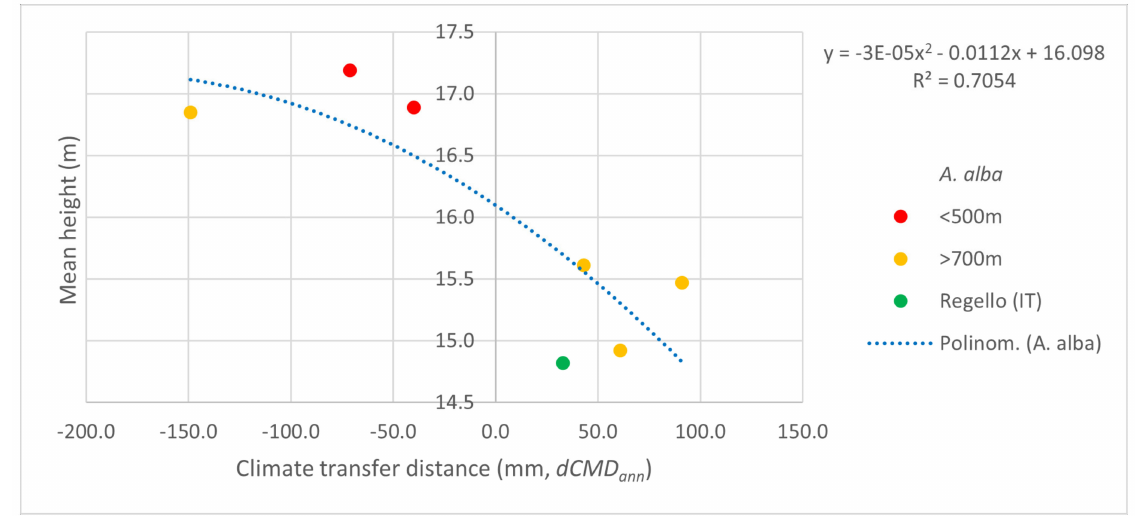
Figure 2. Mean height response and unilateral transfer equation of silver fir provenances to climate transfer distance (current vs past) expressed in annual moisture deficit units (mm precipitation, dCMD ann ) in the trial P í sek. The regression is significant at p ≤